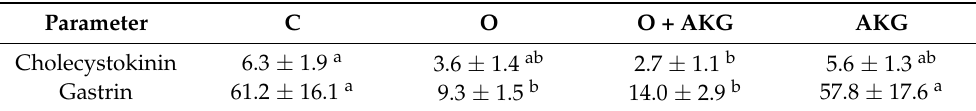
Table 2. Effects of bariatric surgery and alpha-ketoglutarate (AKG) administration on cholecystokinin and gastrin levels in